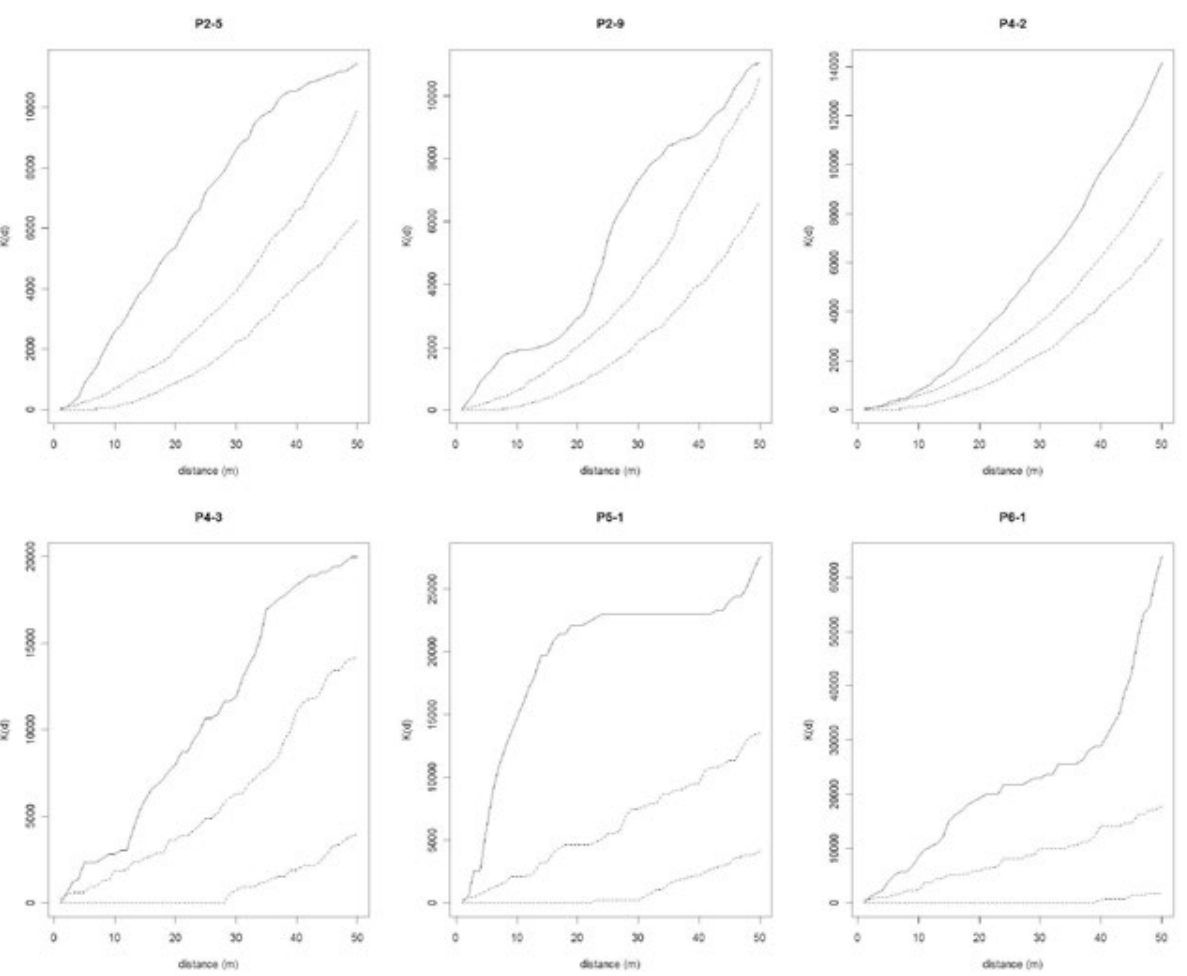
Figure 4. Analysis of estimated K function (solid line) and simulated confidence bounds (dotted lines) for each of the six fire blight affected